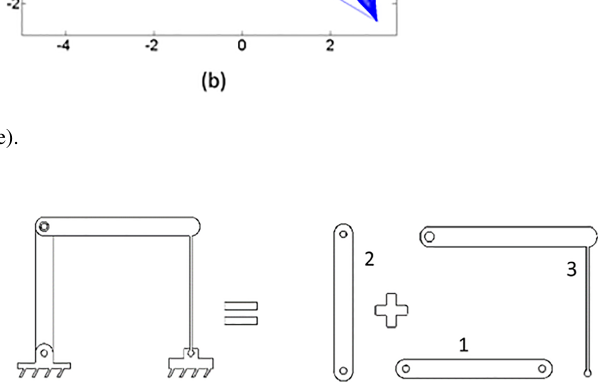
Figure 6. Structure of the compliant wiper